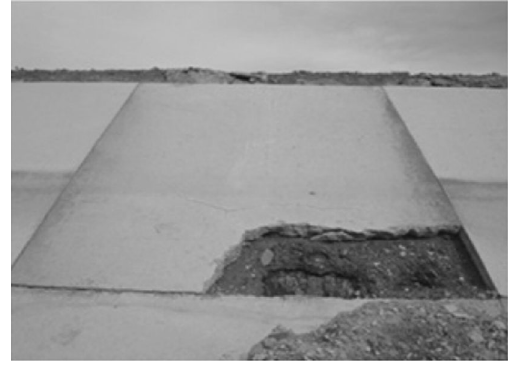
Fig. 1 Failures in the concrete lining (Fahmi et al.